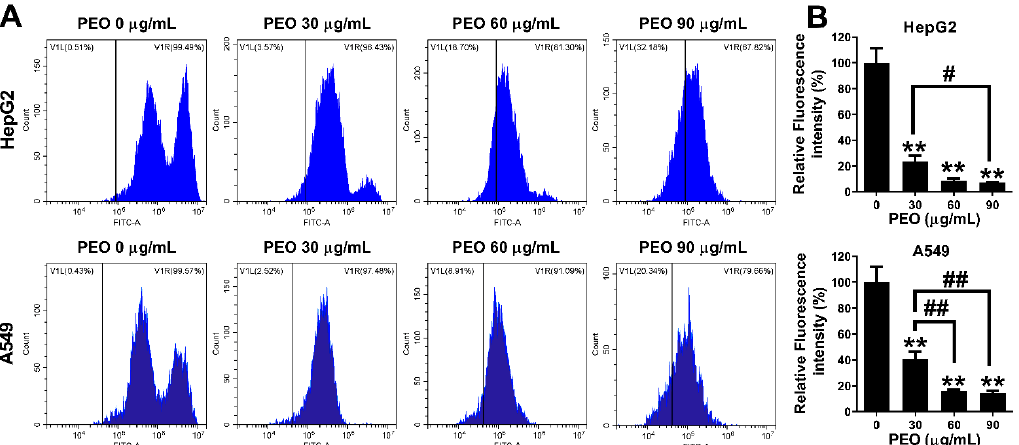
Figure 8. ROS levels of HepG2 and A549 cells treated by PEO. HepG2 and A549 cells were treated with or without different concentrations of PEO (30, 60 and 90 µg/mL) for 24 h, then cells were collected and stained with DCFH-DA. ( A ) Fluorescence intensity was recorded on a Beckman Cytoflex S flow cytometer. ( B ) Relative fluorescence intensity was calculated; the values represent mean ± standard deviation of three independent experiments. # p < 0.05, ## p < 0.01, comparison between the two groups; ** p < 0.01 Compared with the control group.